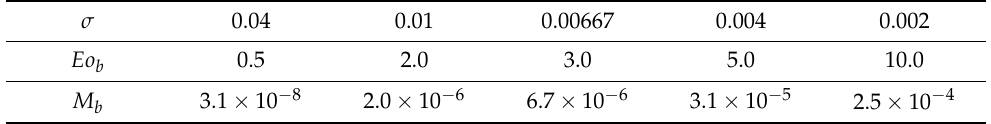
Table 1. The surface tension for the bubbles and the corresponding Eo b and M b